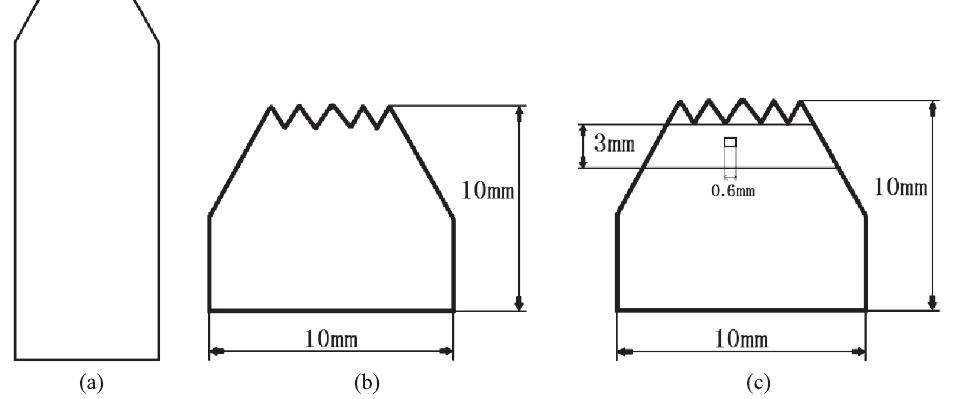
Fig. 2: Schematic diagrams of sample processing showing (a) the specimen after fracture; (b) the specimen near fracture surface; (c) the specimen after polished and etched.